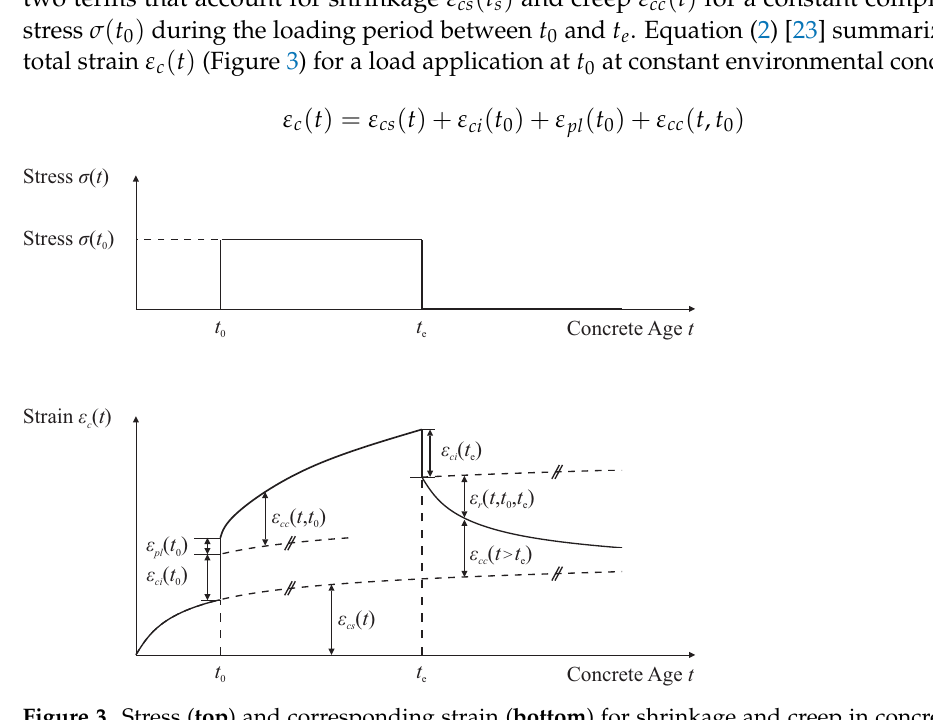
Figure 3. Stress ( top ) and corresponding strain ( bottom ) for shrinkage and creep in concrete as a function of concrete age t . The characteristic points t 0 and t e specify loading and unloading with a constant load σ ( t 0 )